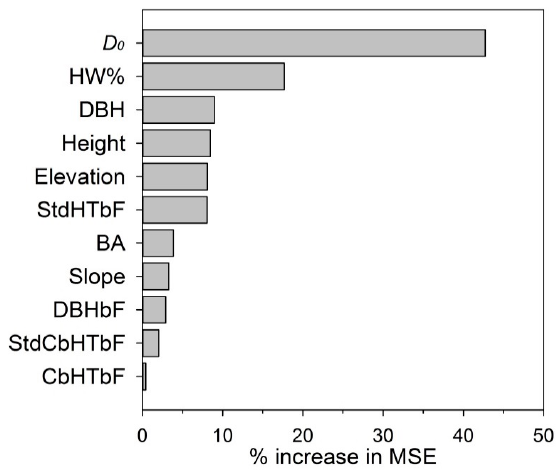
Figure 5. Variable importance (percent increase in mean square error of the Random Forests model when the data for that variable were randomly permuted) of the 11 predictors used to predict spruce budworm defoliation in fir-hardwood mixed stands. High values of percent increase in mean square error indicate more important variables in the Random Forests model. The 11 predictor variables were: average annual defoliation in softwood plots ( D 0 ), percent hardwood basal area (HW%), mean DBH (DBH), mean height (Height), elevation, standard deviation of balsam fir (bF) height (StdHTbF), basal area (BA), slope, mean DBH of bF (DBHbF), standard deviation of bF crown base height (StdCbHTbF), and mean bF crown base height (CbHTbF).